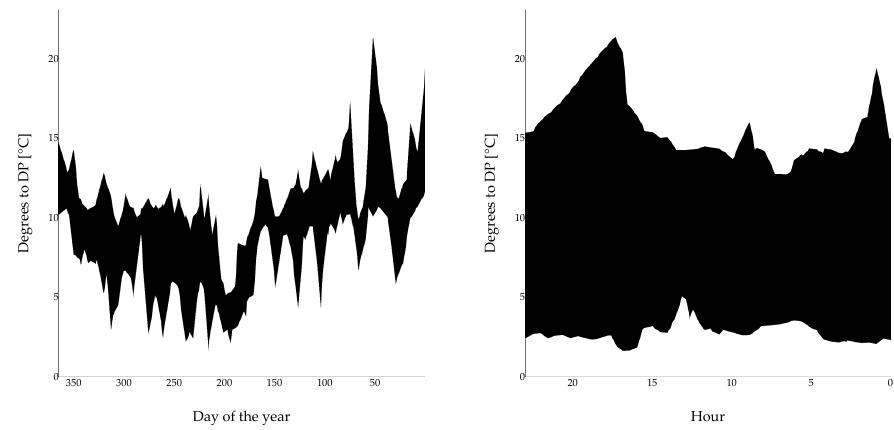
Figure 14. Degrees Celsius needed to reach the dew point temperature.